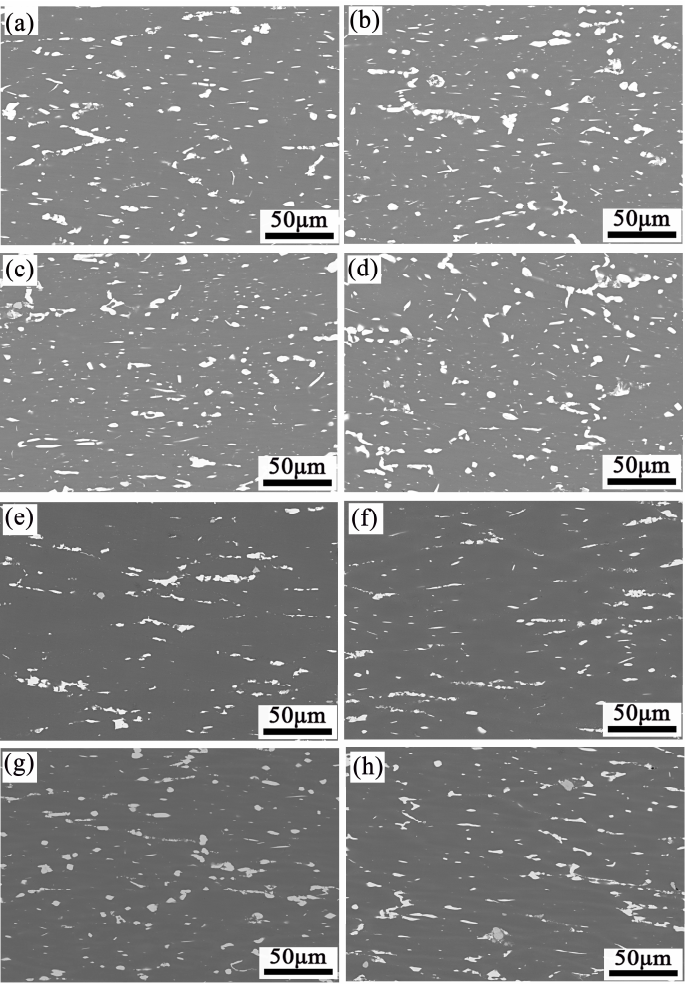
Figure 15. BSE maps of specimens deformed in different conditions: ( a ) 380 °C/0.001 s −1 , ( b ) 380 °C/0.01 s −1 , ( c ) 380 °C/0.1 s −1 , ( d ) 380 °C/1 s −1 , ( e ) 440 °C/0.001 s −1 , ( f ) 440 °C/0.01 s −1 , ( g ) 440 °C/0.1 s −1 , ( h ) 440 °C/1 s −1 .